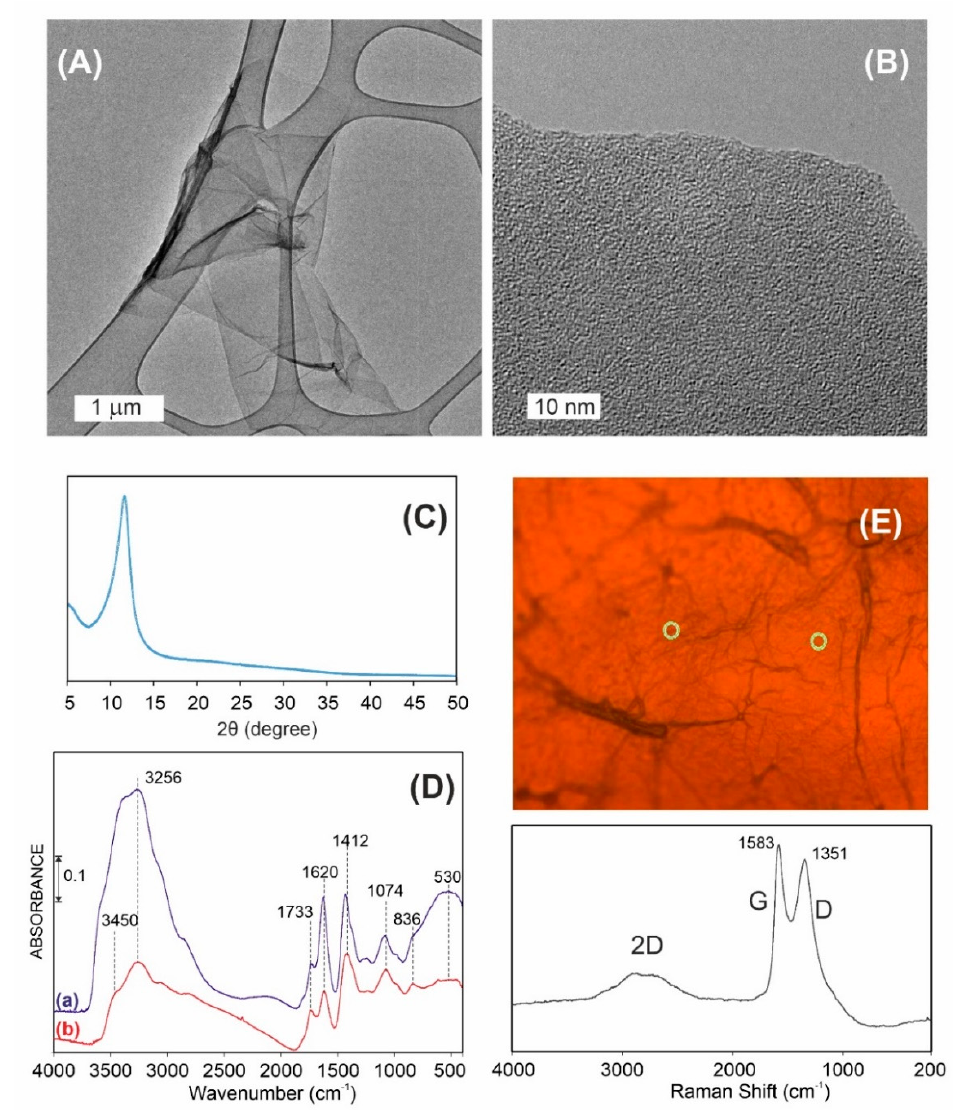
Figure 2. Characterization of obtained GO. The results from ( A ) and ( B ) HRTEM, ( C ) XRD, ( D ) FTIR, and ( E ) Raman spectroscopy analysis.